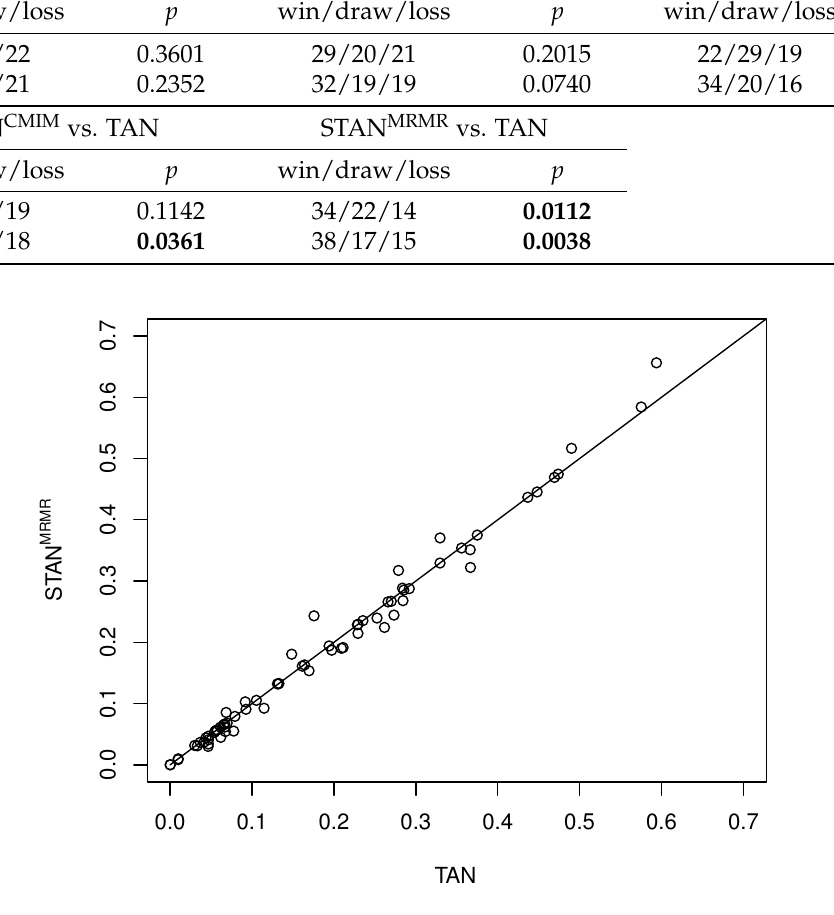
Table 2. Win/draw/loss records of different versions of STAN vs. TAN in terms of ZOL and RMSE on 70 data sets. STAN MI vs. TAN STAN SU vs. TAN STAN JMI vs. TAN